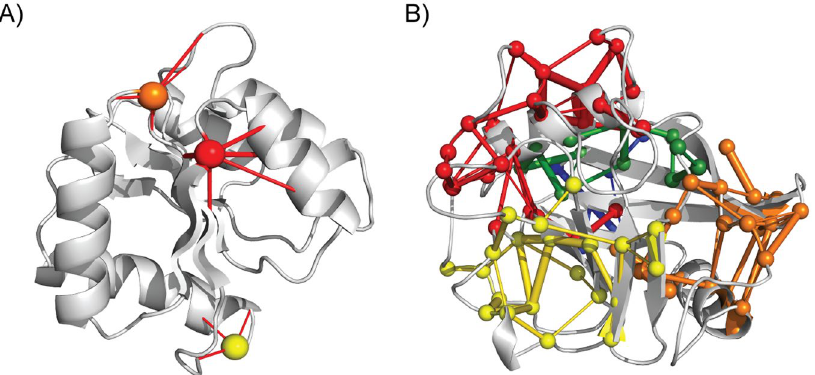
Figure 2. Schematic representation of hubs and connected components. Hubs are nodes that have a degree higher than the average degree of the nodes of a network. In PSN, we consider as hubs only those nodes having a number of edges greater than or equal to three. Hubs with a degree of three, four and five are shown in yellow, orange and red, respectively ( A ). The connected components are clusters of linked nodes with no edges in common with nodes that belong to the other clusters of the PSN. As an example, five connected components are shown ( B